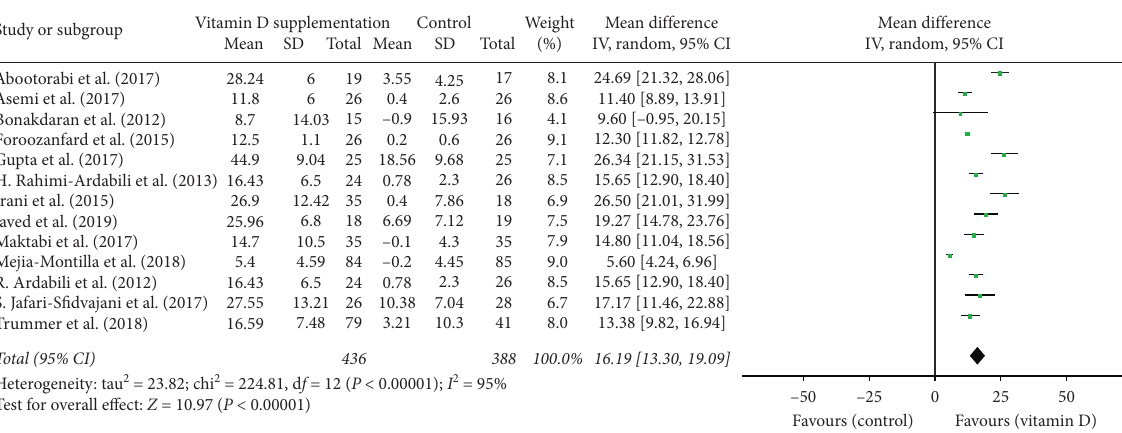
Figure 3: Forest plot of vitamin D concentration in experimental and placebo